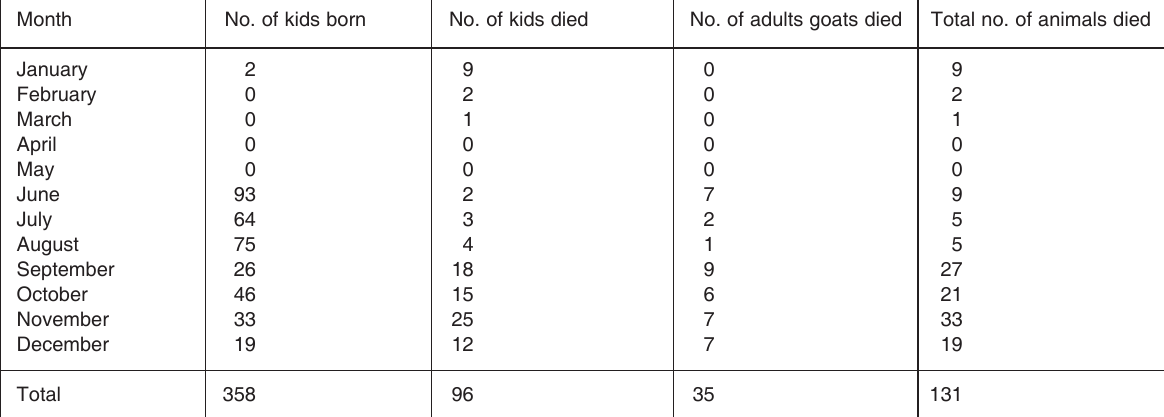
TABLE 2 The number of kids born as well as mortalities among young and adult goats due to disease and non-specific causes in all goat-flocks in which animals were selected for study during 1999–2000 in six villages in Okakarara district Month No. of kids